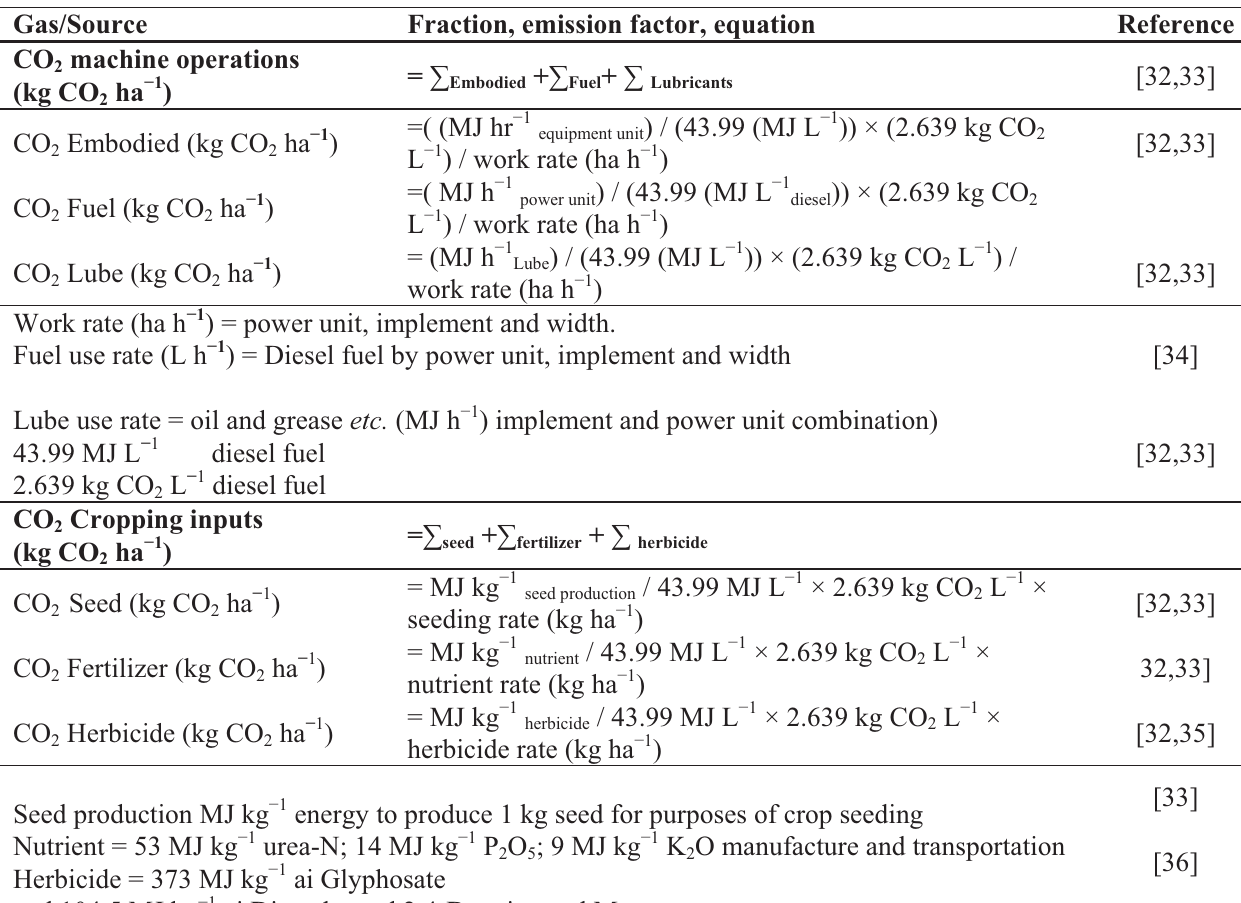
Table A4. Sources of carbon dioxide emissions related directly and indirectly to on-farm fossil fuel use for each crop and